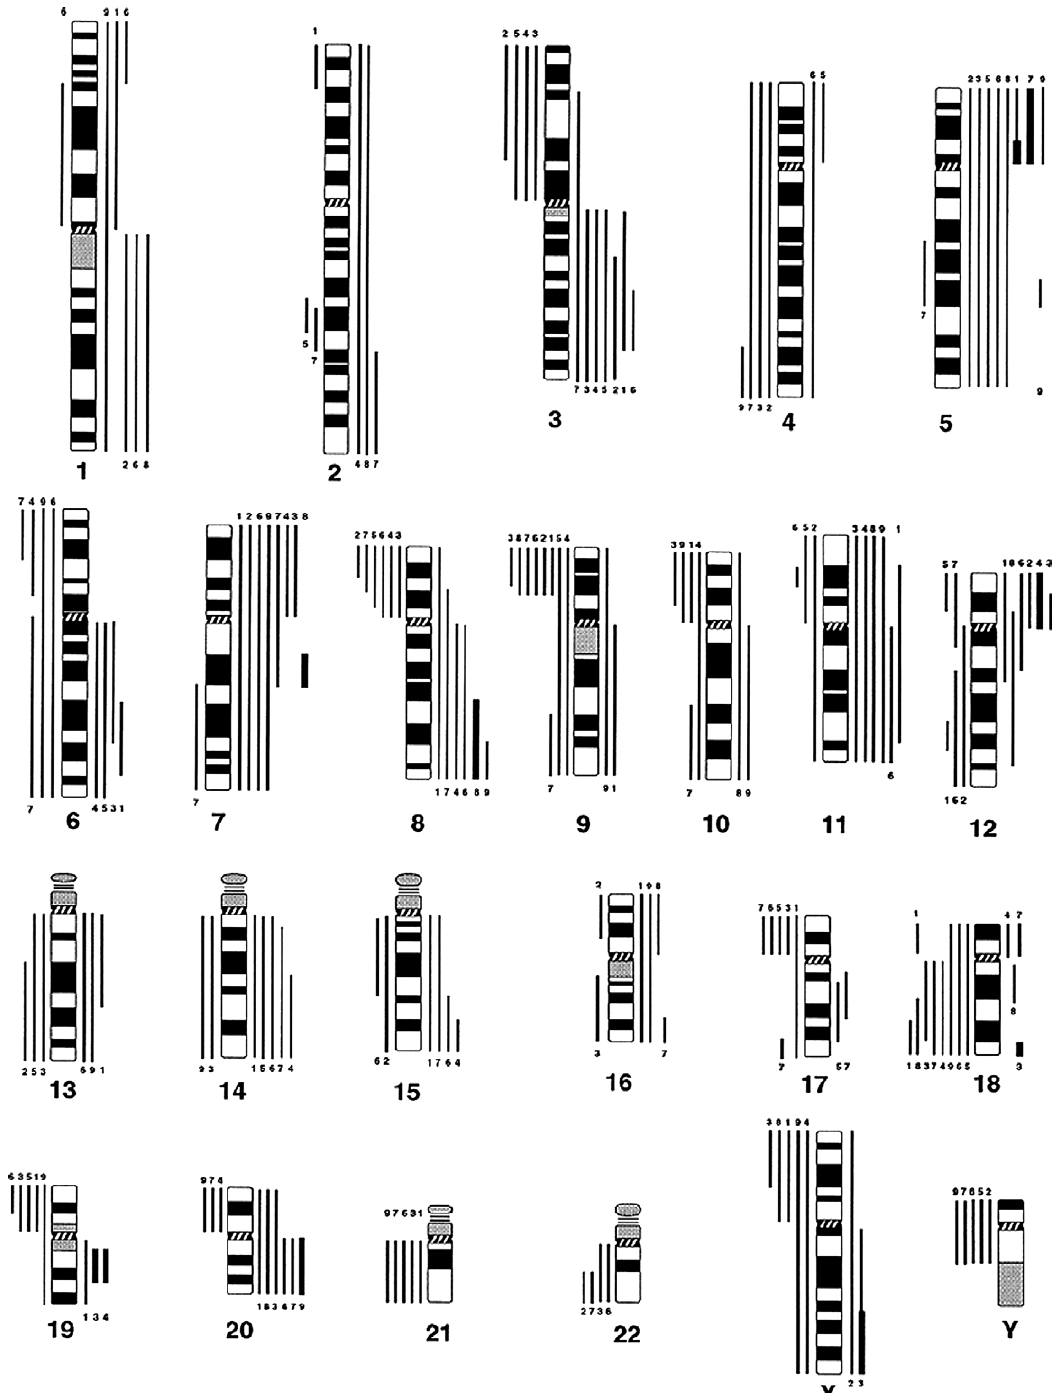
Fig. 3. Karyogram of chromosomal gains and losses in nine pancreatic carcinoma cell lines obtained by CGH. Vertical lines on the left side of each chromosome ideogram represent loss of genetic material, whereas those on the right side correspond to a gain. Amplification sites are represented as solid squares or bars. Each cell line can be identified by the case number on the top of each line: BxPC-3 (1), MIA-PaCa-2 (2), PANC-1 (3), SU.86.86 (4), CFPAC-1 (5), Capan-2 (6), Capan-1 (7), AsPC-1 (8), Hs766T (9)